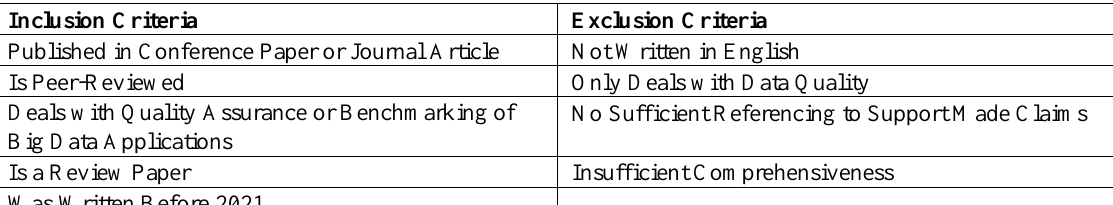
Table 2. Inclusion and Exclusion Criteria